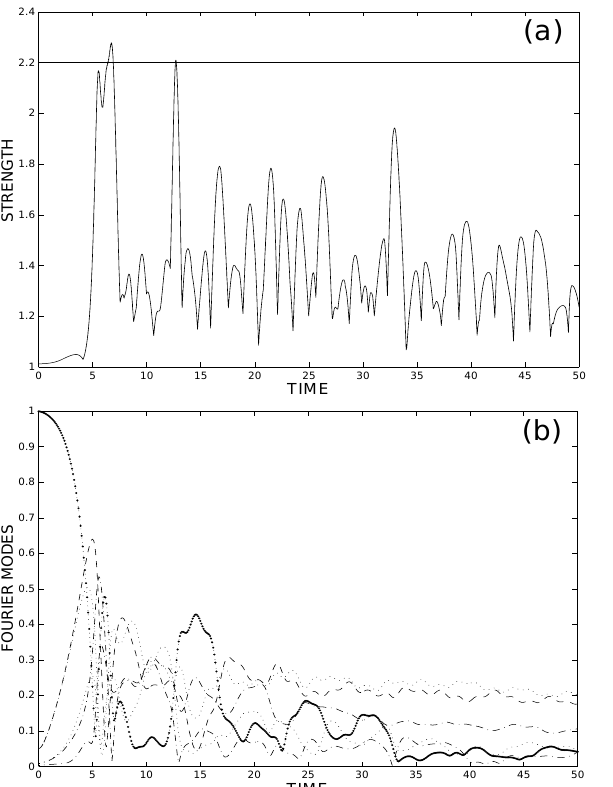
Fig. 12: Nonlinearly damped HONLS eq. ǫ = 0 . 05 , β = 0 . 5 , Fig. 12. Nonlinearly damped HONLS equation (cid:15) = 0 . 05, β = 0 . 5, 0 = 0 . 005: the time evolution of (a) the strength S(t) , (b) the main Γ = 0 . 005 : the time evolution of (a) the strength S ( t ) , (b) the Fourier modes, for initial data (17). main Fourier modes, for initial data (17).